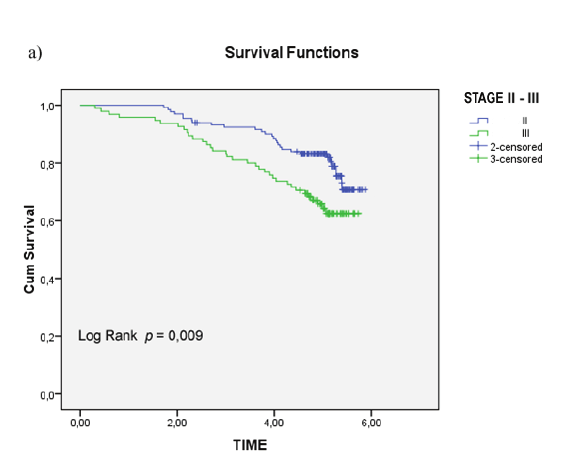
Figure 2c: Overall survival (OS) according to circulating CA 19.9 (< 37U/ml vs ≥ 37U/ml, p= 0.004).